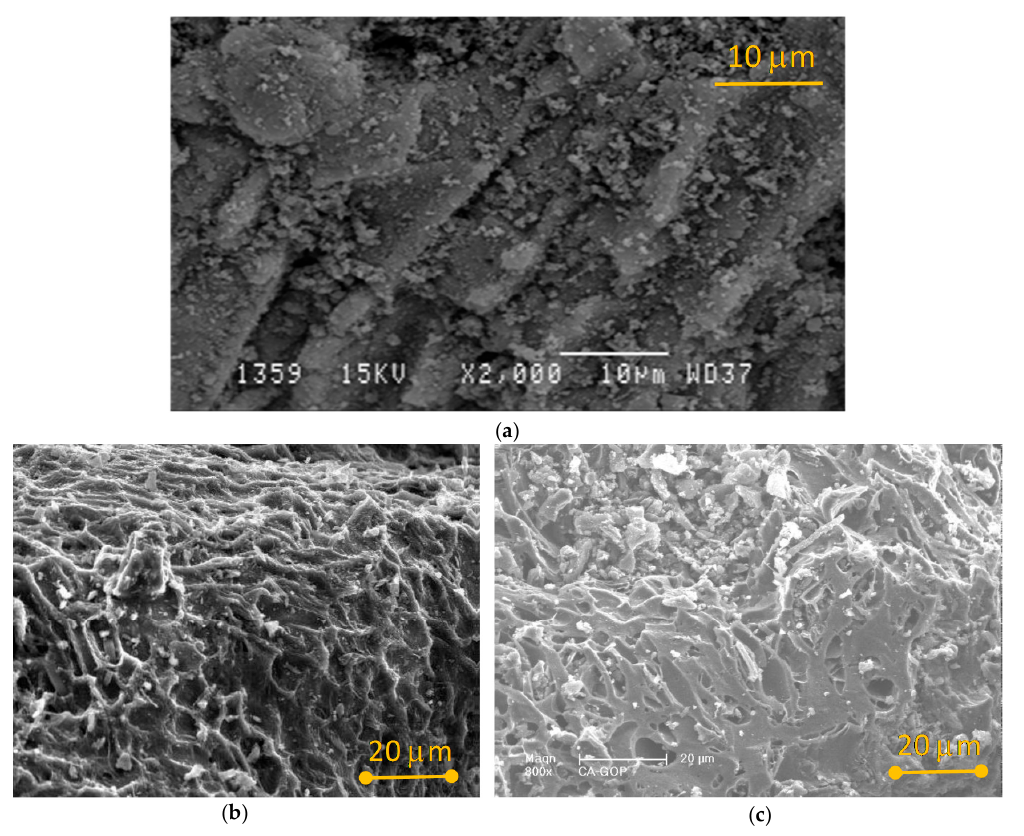
Figure 2. Scanning electron microscopy micrographs of sample: ( a ) AC-H 3 PO 4 ; ( b ) AC-CO 2 ; and ( c ) AC-H 2 O.